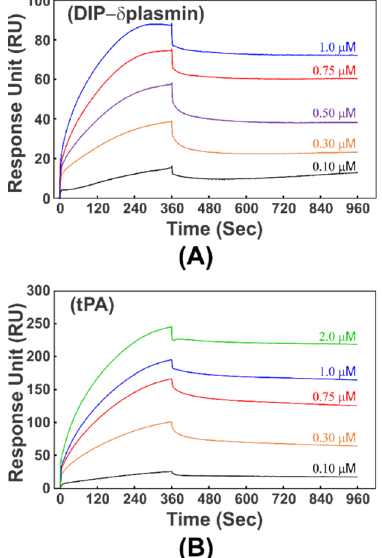
Figure 4. Interaction of KD1-Y11T/L17R-K COOH with DIP-δplasmin and tPA as measured by SPR. ( A )